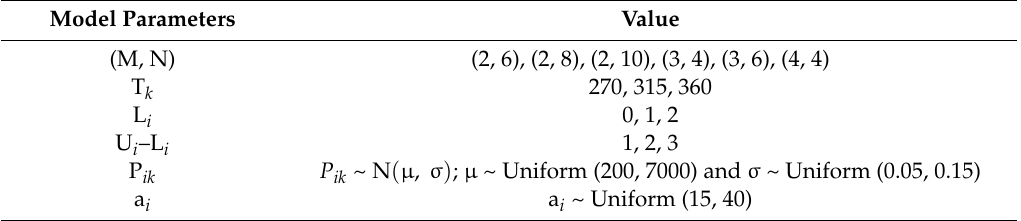
Table 2. The settings for the model parameters, borrowed from